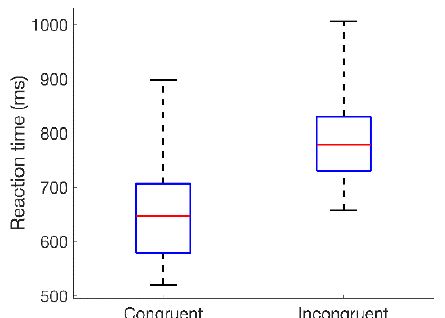
Figure 4. Box-and-whisker plots summarizing the distributions of reaction times for all 18 subjects to congruent and incongruent color–word stimuli. Values represented are median (across sessions) average reaction times relative to the onset of the color–word stimulus, with averages taken across the 24-word presentations in each session. Red lines indicate the medians of each distribution; blue boxes span the first to third quartiles; and whiskers extend to the extreme values.